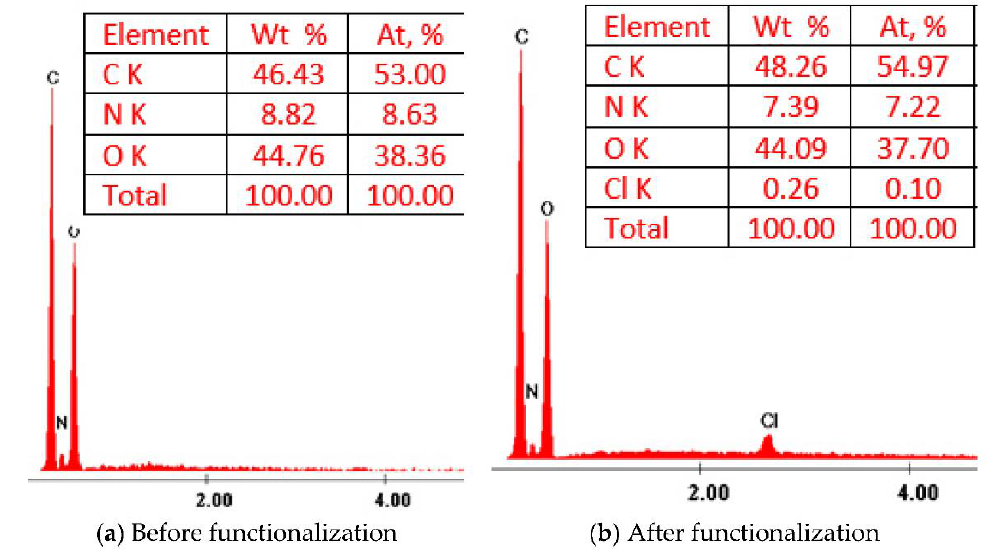
Figure 1. X-ray dispersion (EDX) spectra of unfunctionalized and functionalized bio material.